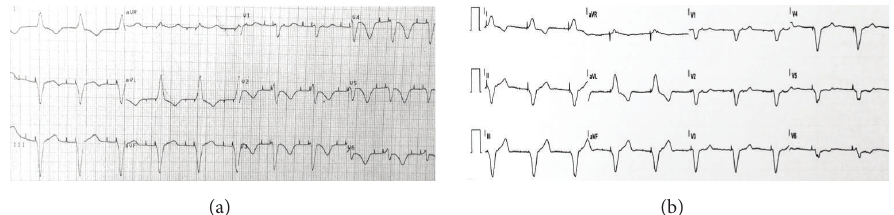
Figure 1: (a) Initial electrocardiogram showing an atrioventricular sequential paced rhythm with left bundle branch block morphology complexes, no ST-segment deviation, deeply inverted T waves on DI, aVL and precordial leads, and a prolonged QTc interval (560 ms). (b) Electrocardiogram 3 months after discharge.